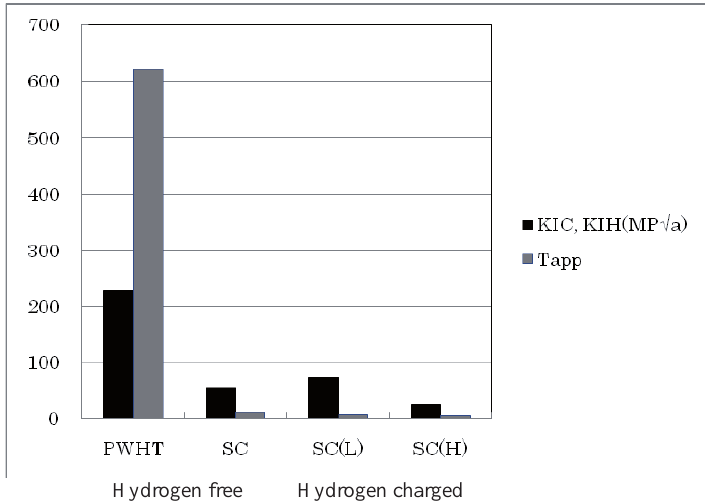
Fig.8. Comparison of fracture toughness and the tearing modulus at an upper shelf temperature of 313 K (40 (cid:864)